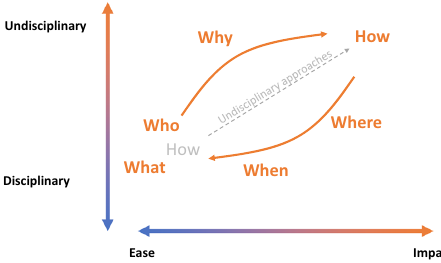
Fig. 5 Motivations for arriving at undisciplinary interactions (an inter- epistemological ways of knowing) in relation to how easy it is to implement and how much impact it may have. WHY and HOW were perceived by participants as undisciplinary, with HOW having the largest impact and WHY was easiest to agree on. WHAT, WHO, and WHEN were most closely identi fi ed with each discipline. WHAT, WHO, WHEN, WHERE, WHY, and HOW are de fi ned in Box